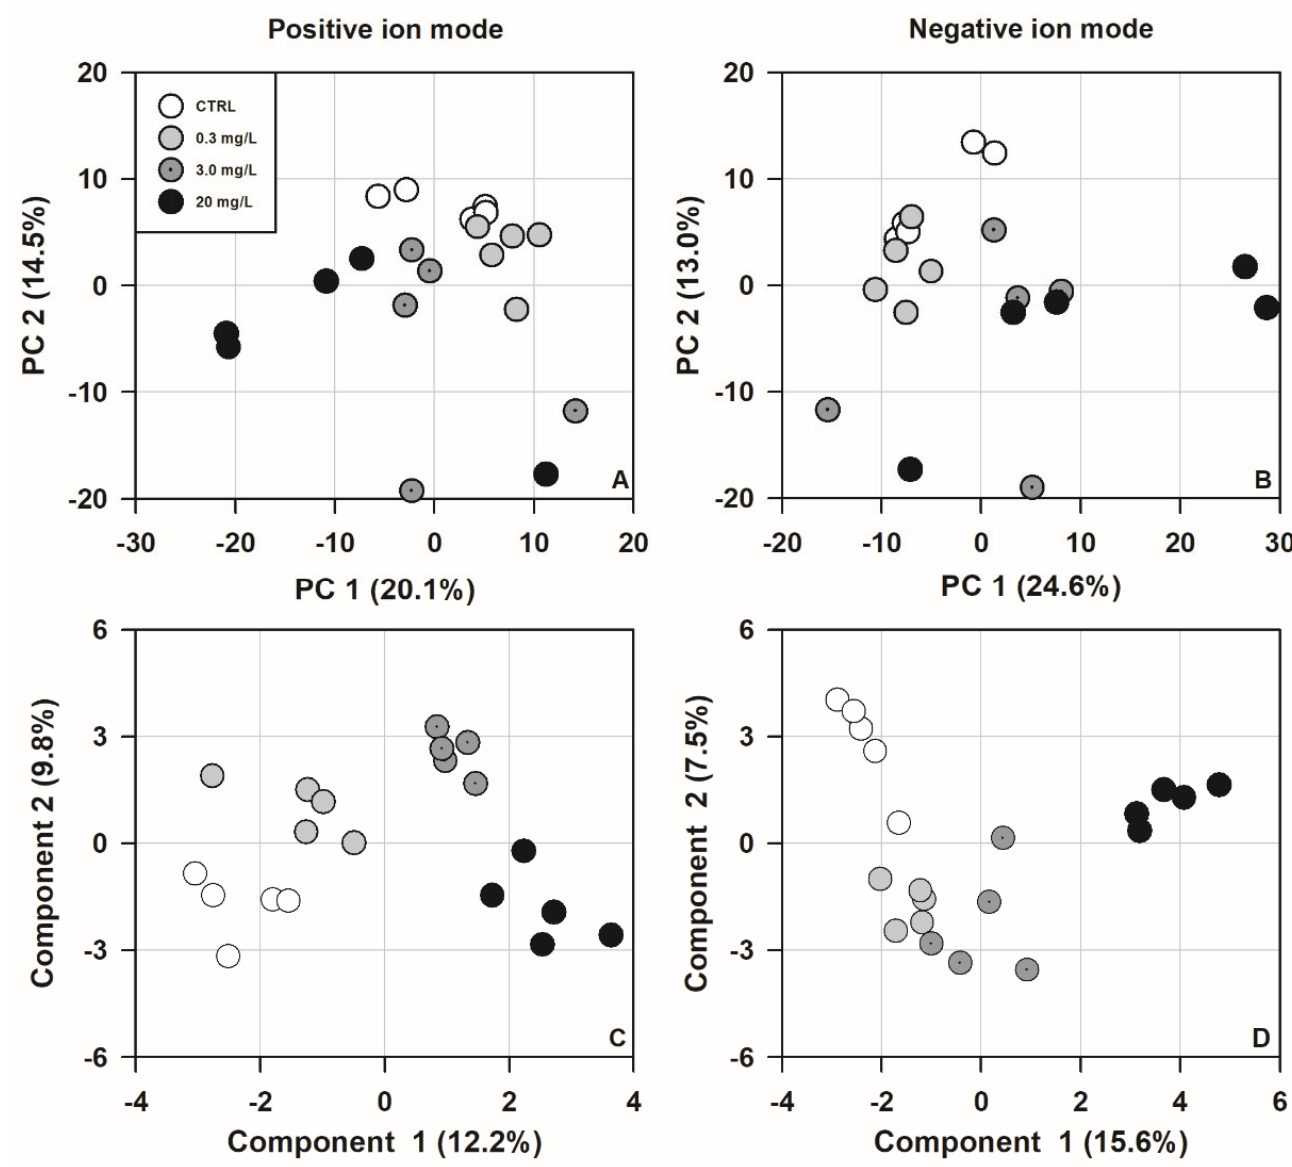
Figure 4. Score plots for principal component analysis (PCA), in the positive ( A ) and negative ( B ) ion mode, and partial least squares–discriminant analysis (PLS-DA), in the positive ( C ) and negative ( D ) ion mode of hepatic metabolite profiles showing separation among different treatment groups of Trachemys scripta elegans juveniles.